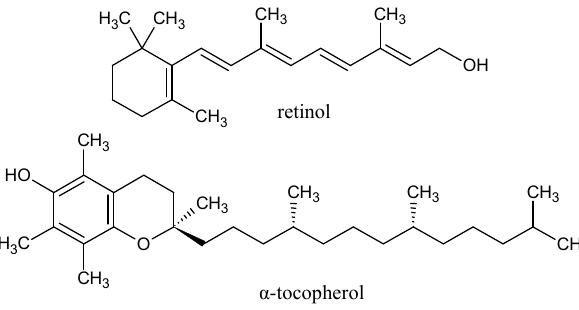
Figure 1. Molecular structure of retinol and α -tocopherol. Raman spectroscopy belongs to the group of vibrational spectroscopy